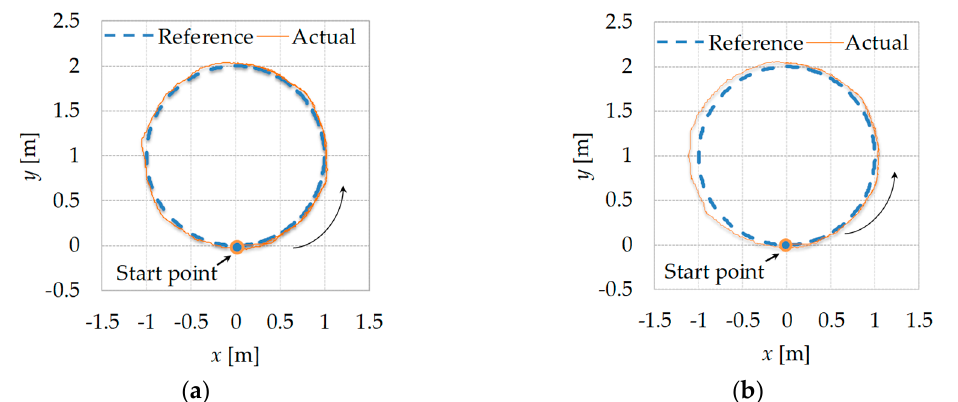
Figure 12. Path tracking results of experiment with parameter changes: ( a ) with robust compensation and ( b ) non-robust compensation.